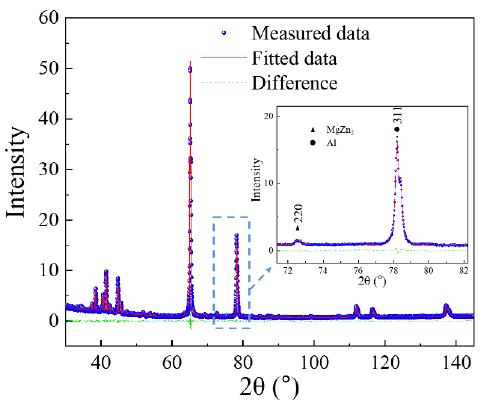
Figure 5. The diffraction pattern and the fitted pattern of the cold-rolled sample.